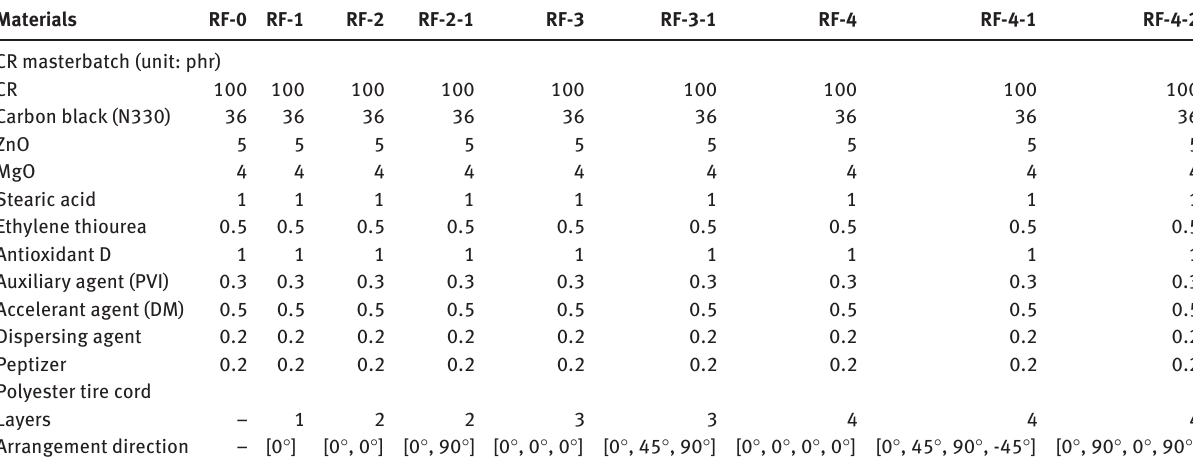
Table 1: Compositions of CR masterbatch and polyester tire cord.